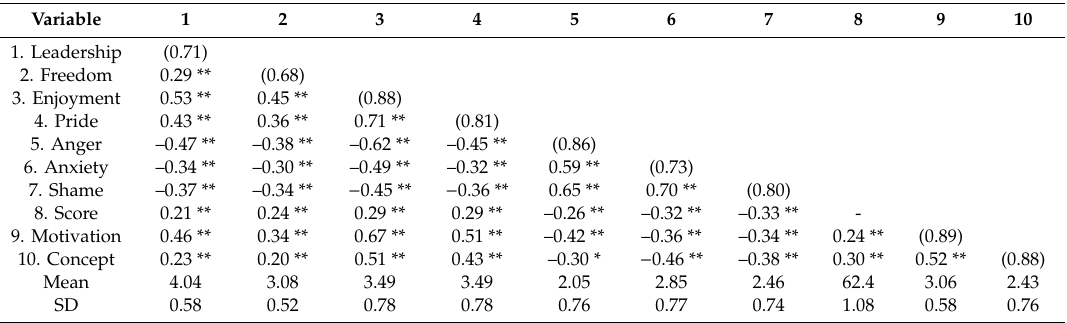
Table 1. Descriptive statistics and correlation